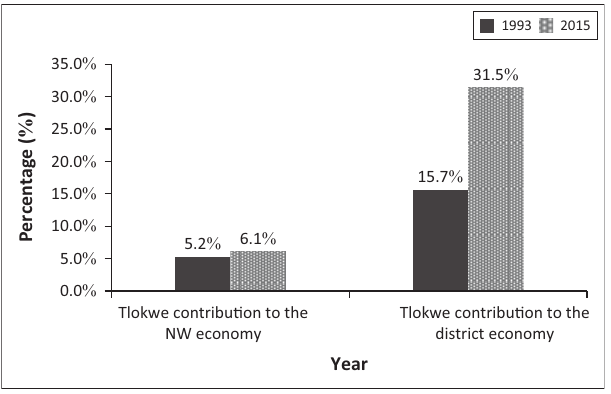
FIGURE 2: Tlokwe sectoral contribution (gross value-added – GVA) 1997, 2008 and 2015.